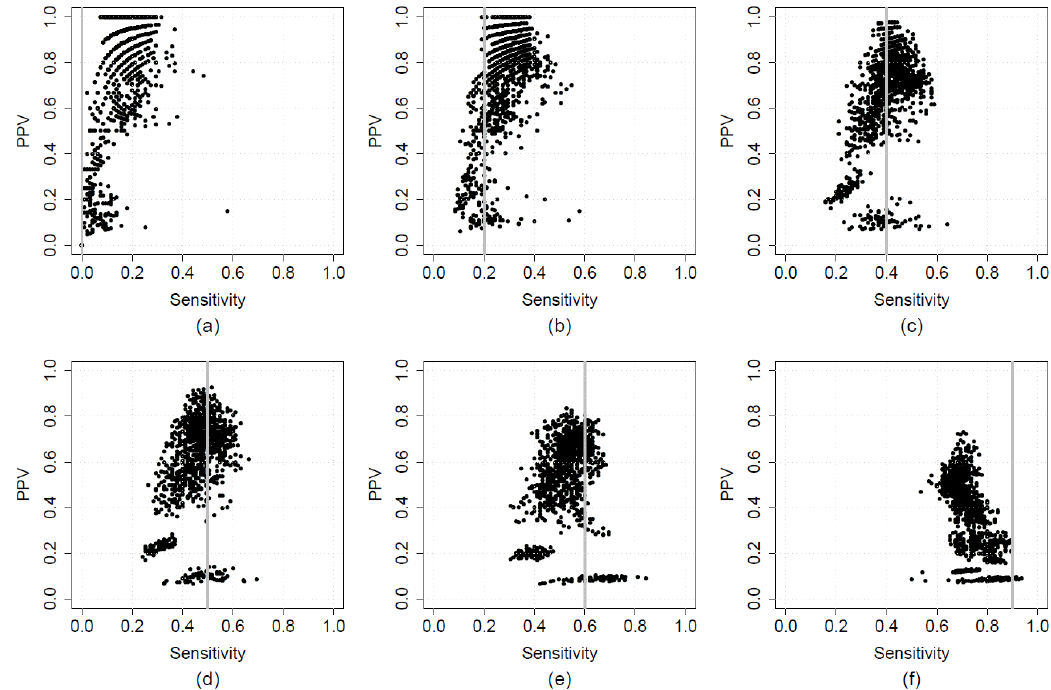
Figure 2. Validation positive predictive value (PPV) and sensitivity for candidate state-wide high-risk foot (HRF) models, plotted over a grid of minimum sensitivity thresholds from 0 to 0.9 ( a – f ). The minimum sensitivity thresholds are indicated by vertical grey lines. In each panel, black dots depict data for individual models.